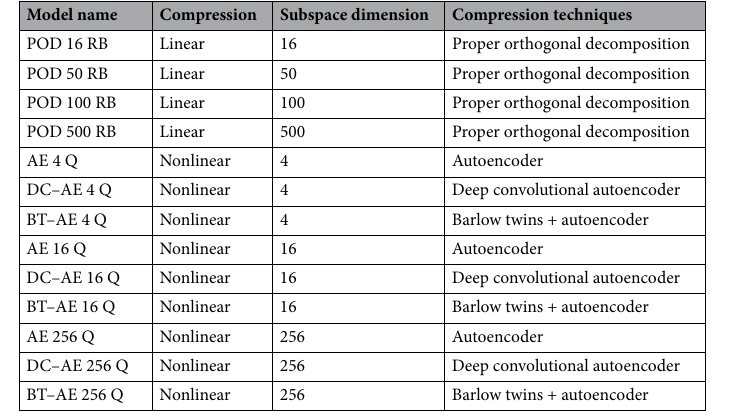
Table 2. Summary of naming for each